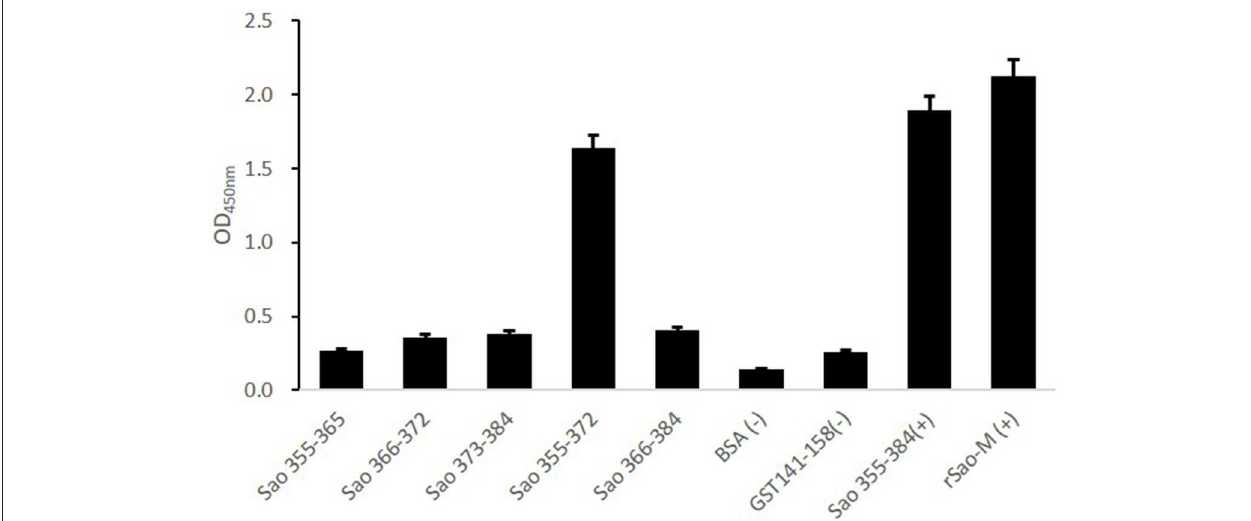
FIGURE 5 | ELISA detection of the core epitope. To determine the core epitope of immunodominant epitope peptide Sao 355 − 384 , ELISA plate was coated with five truncated peptides or GST 141 − 158 (negative control of irrelevant peptide) or Sao 355 − 384 (positive control of synthetic peptide) or rSao-M protein (positive control of protein) and BSA. Then, serum samples from BALB/c mice that were immunized with Sao 355 − 384 plus Freund’s adjuvant were detected. The absorbance at 450nm for the peptide Sao 355 − 372 was significantly higher than GST 141 − 158 ( P < 0.01) and BSA ( P < 0.01).